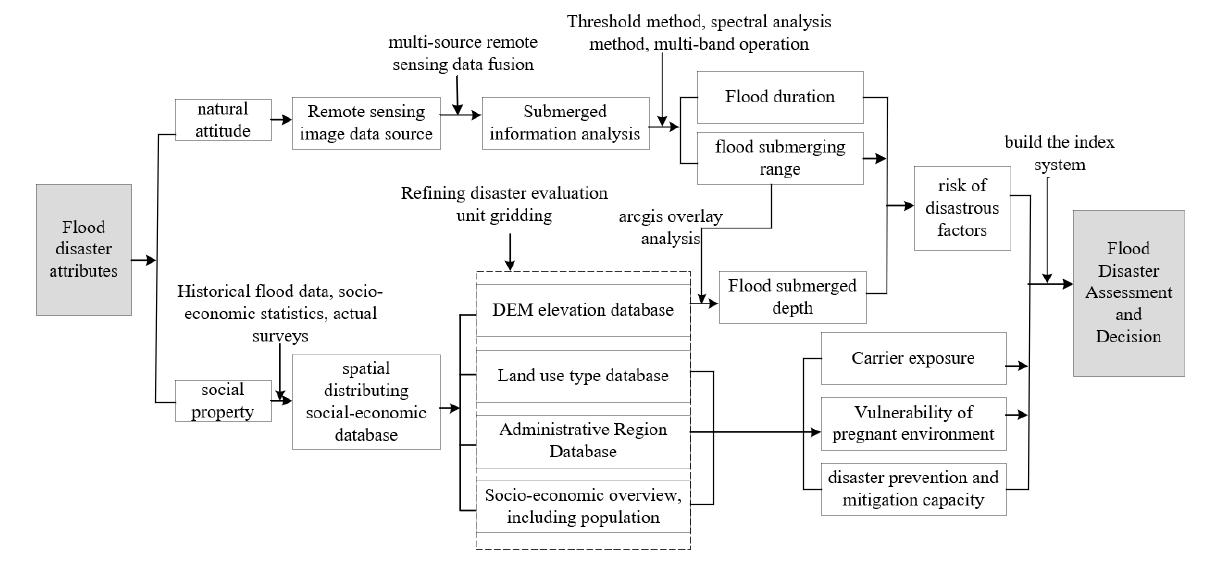
Figure 1. Flow chart of flood disaster monitoring and evaluation